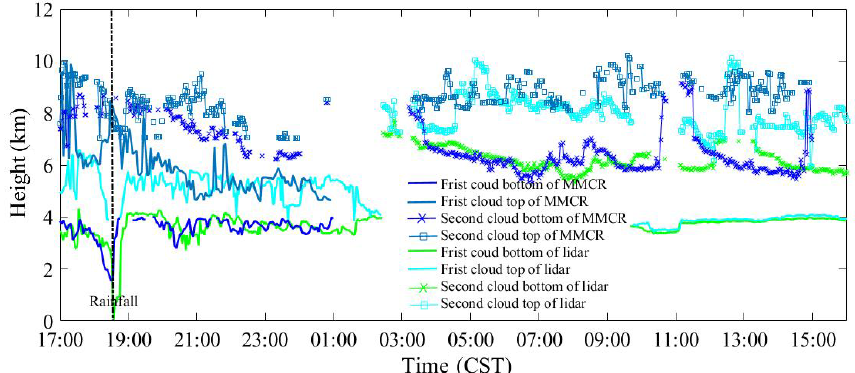
Figure 11. Cloud boundary detected by the lidar and MMCR from 4 to 5 March